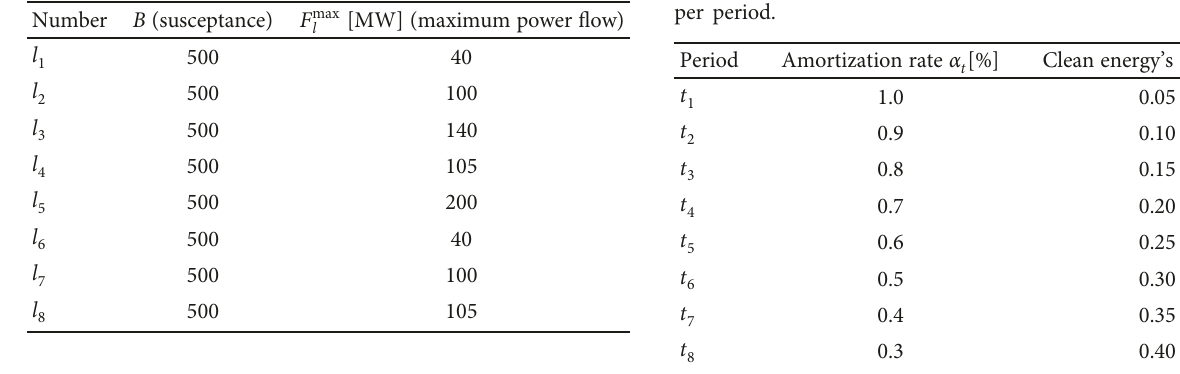
Table 17: Data for transmission